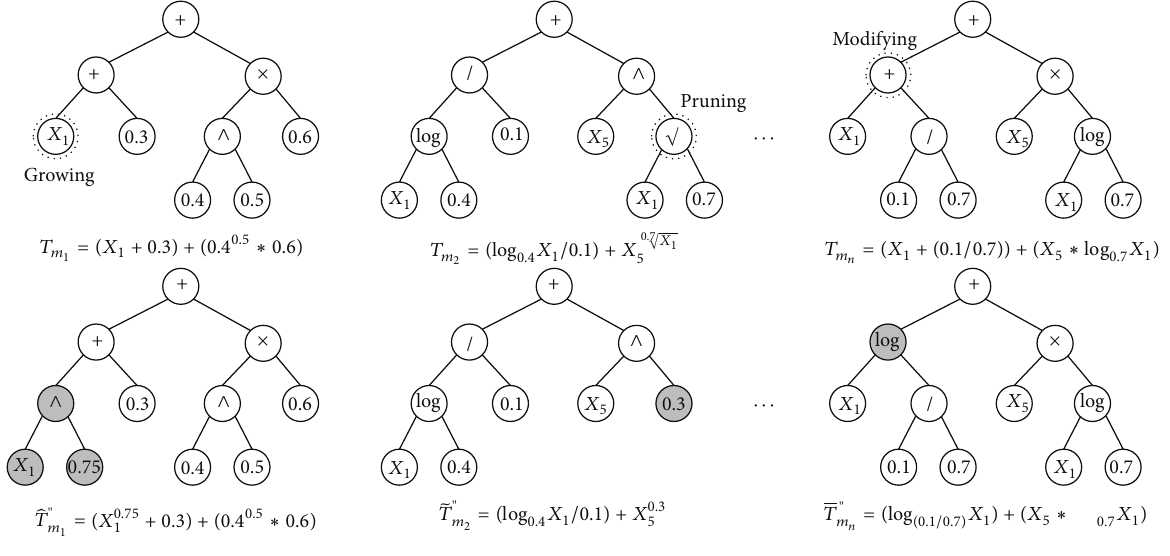
Figure 9: An example of the proposed GP mutation.